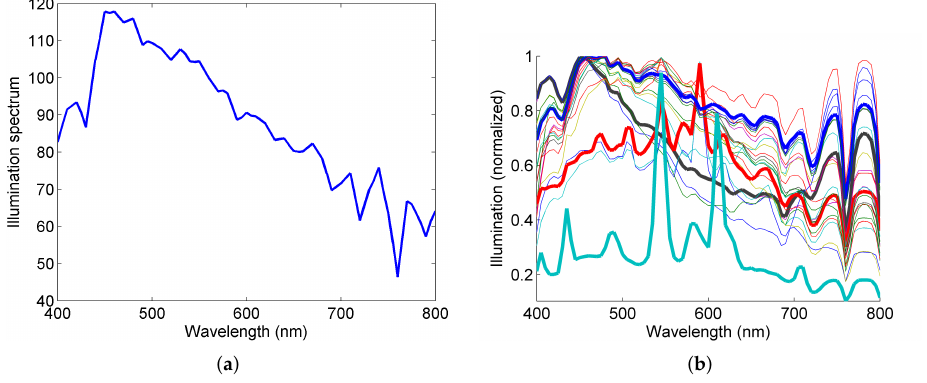
Figure 4. Illumination spectrum of D65 illumination ( a ) and 25 illuminations measured in outdoor scenarios at various locations and times in Barnard dataset ( b ). The thick lines show the general trends of these illuminations in (b).